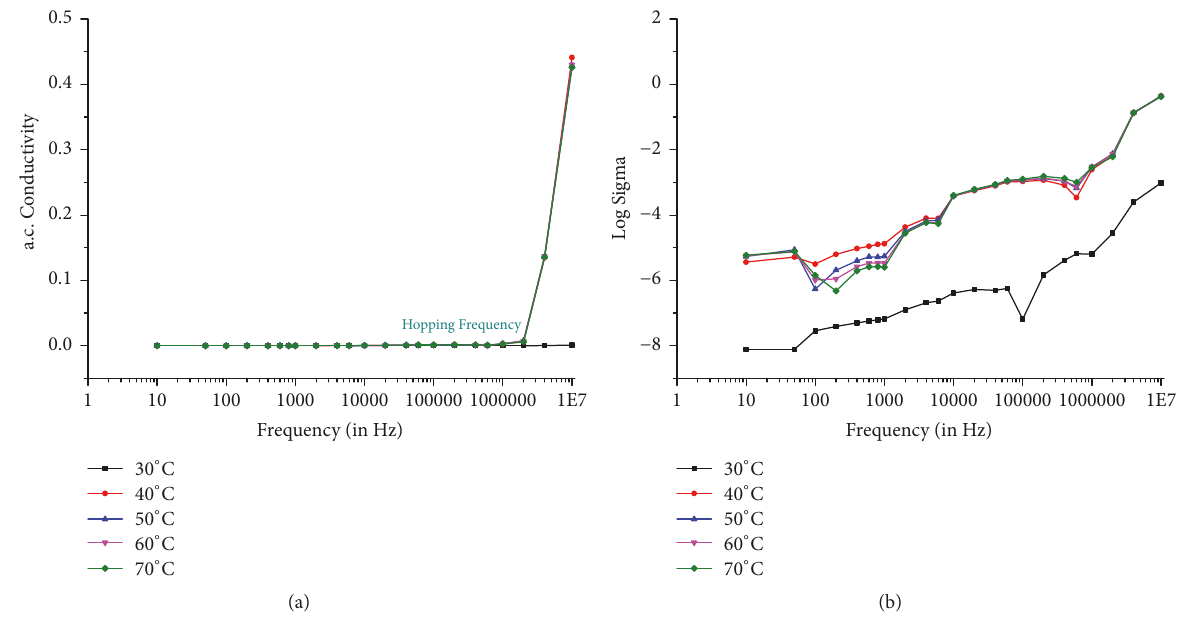
Figure 12: (a) AC conductivity versus frequency. (b) Jonscher’s plot of log sigma versus